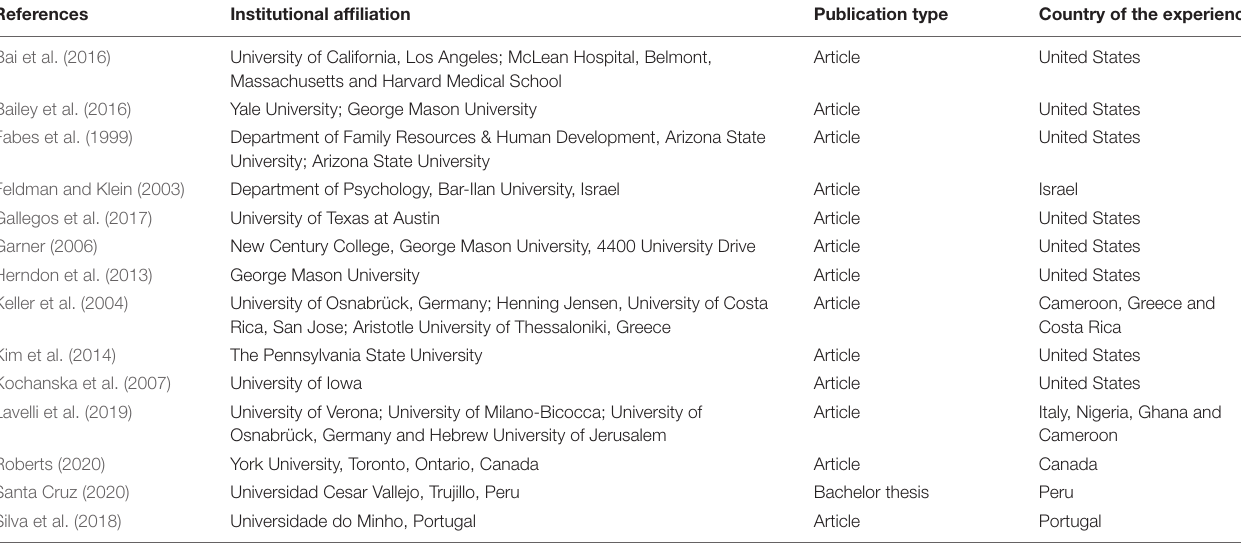
FIGURE 1 | Study selection flow chart. TABLE 1 | Extrinsic